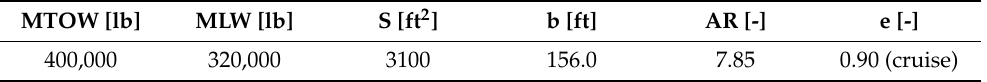
Table 1. Basic data for a large T-category FAR/CS 25 medium- to long-haul commercial jet.